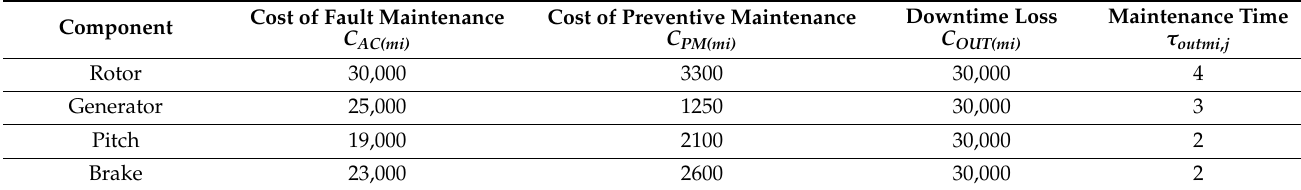
Table 3. Critical components of OWTs and cost parameters. (¥/year).